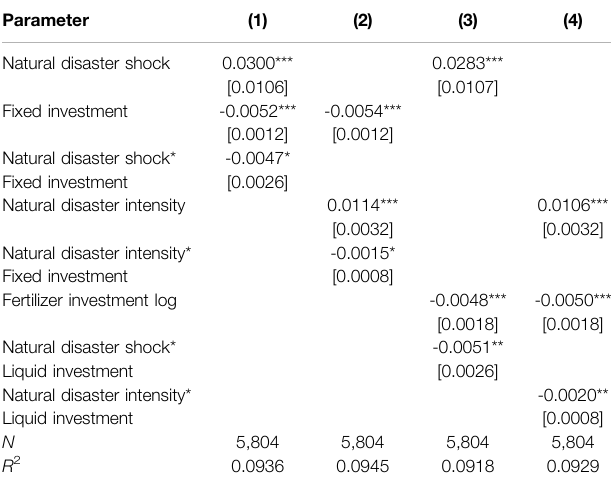
TABLE 6 | Test results of the moderating effect of